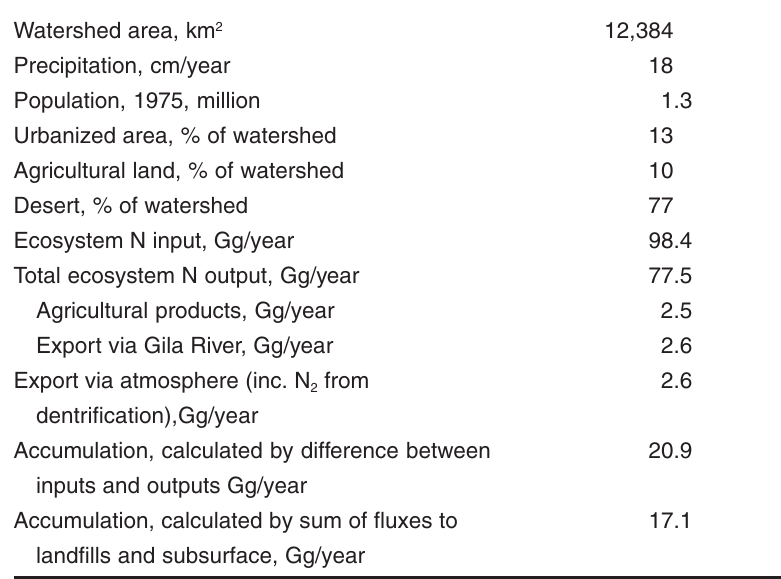
Key Attributes of the Central Arizona-Phoenix Ecosystem